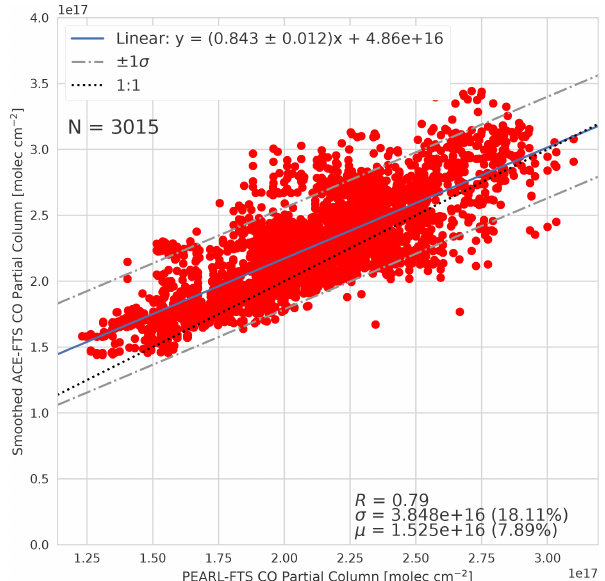
Figure 10. Correlation plot for ACE-FTS vs. PEARL-FTS CO par- tial columns in the range of 9 . 33 to 66 . 58km for the period from 25 February 2007 to 18 March 2020. R , σ , and µ are defined in the same way here as in Fig.